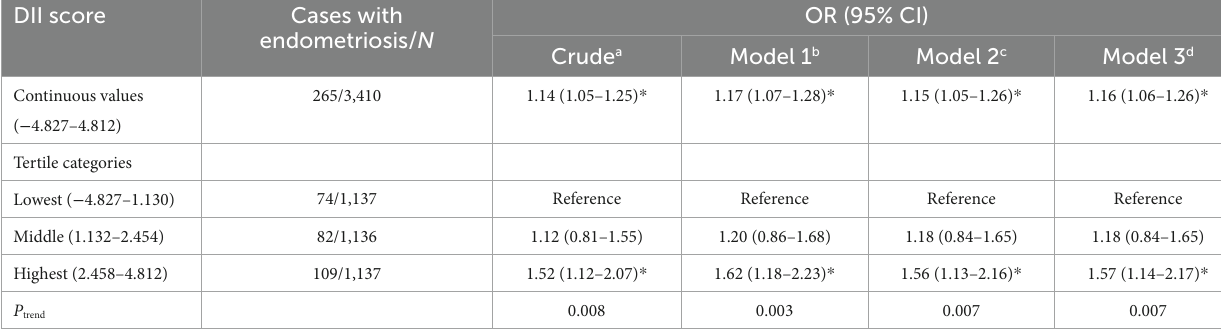
TABLE 2 Associations between the DII score and Endometriosis among the total cohort.